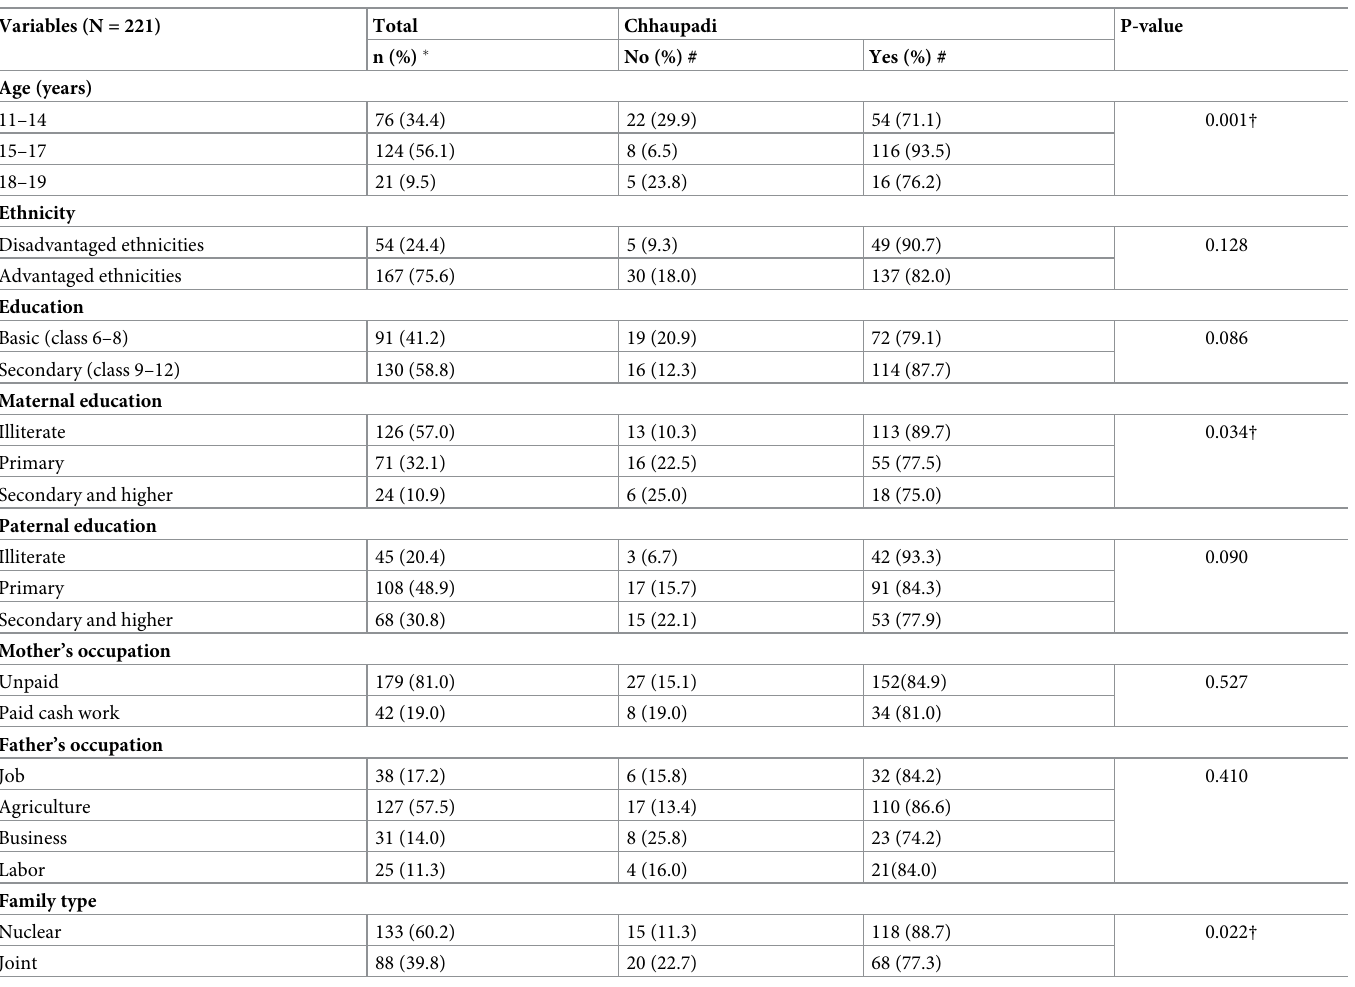
Table 1. Chhaupadi practice stratified by sociodemographic variables among adolescent girls aged 11–19 years in Mangalsen municipality, Achham district,